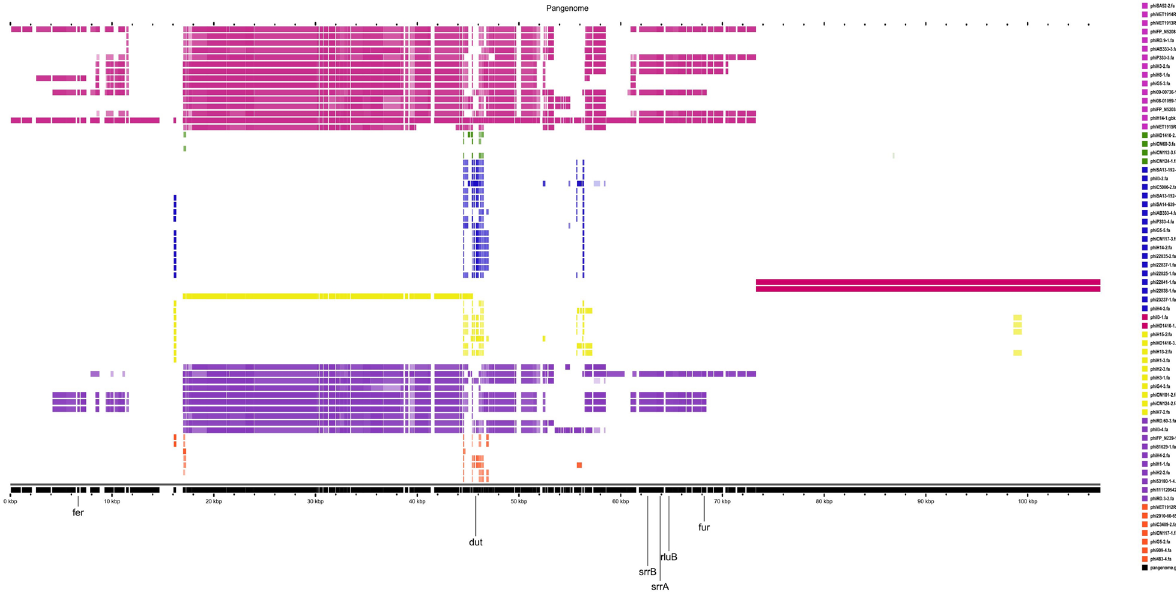
Figure 2. Pan-genome analysis of genome of the prophages. The pan-genome was generated as linear map with brown color below the background line (black), each linear genome sequence represents an individual putative prophage and are color-coded clade wise (clade 1 = marron, clade 2 = green, clade 3 = blue, clade 4 = dark red, clade 5 = yellow, clade 6 = purple, and clade 7 =